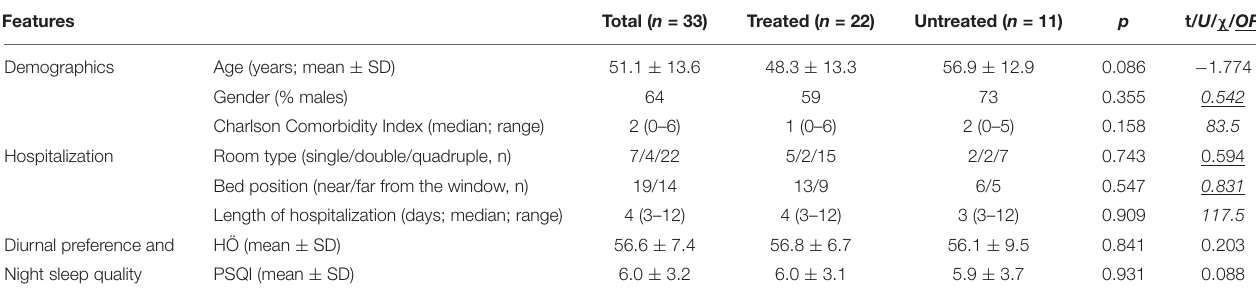
TABLE 1 | Patients’ features, by treatment